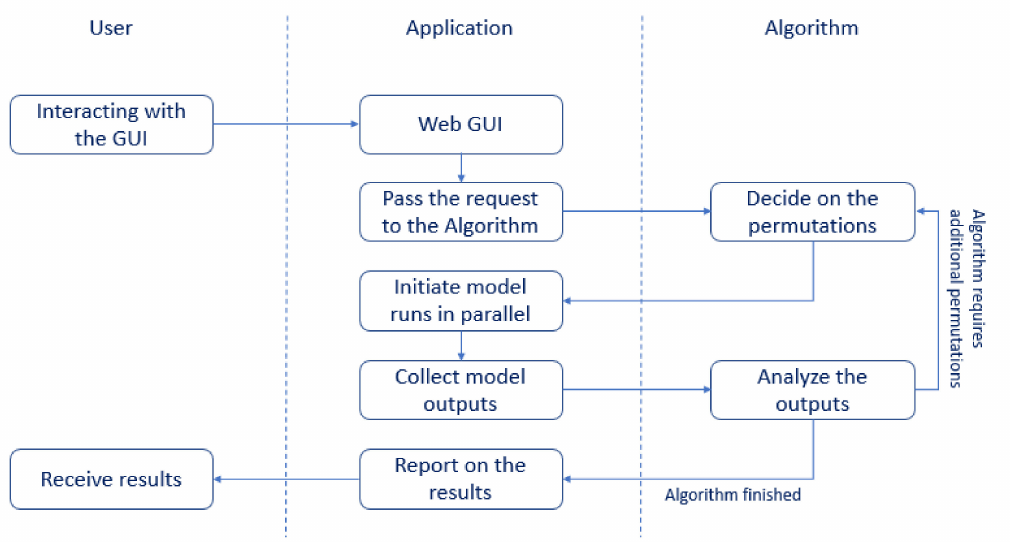
Figure 3. Application layer